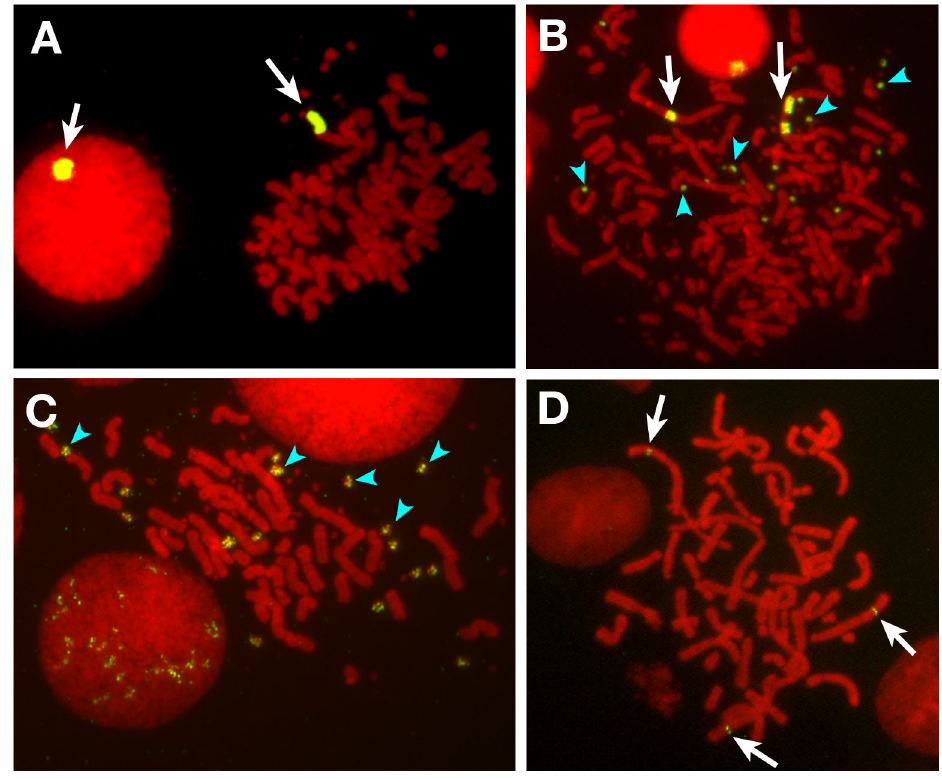
Figure 3. Detection of the amplified plasmid sequence by FISH. Representative images obtained in this study are shown. Plasmid pTV-Rep-P bearing full-length Rep-P sequence was transfected to COLO 320DM cells (A to C) or CHO-DG44 cells (D). Metaphase chromosome spreads were prepared from the stable transfectants, and the plasmid sequence was detected by FISH. Long HSR appeared in the metaphase cells (A and B) or a interphase cell (A). The DMs with plasmid sequence appear in the metaphase cells in panel B and C as well as an interphase cell in panel C. In CHO-DG44 cells, the same plasmid did not generate long HSR, instead it remained as the short HSRs that were arrowed (D), as explained in Figure 1. doi: